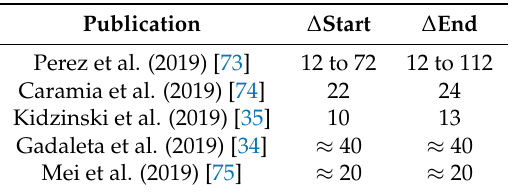
Table 2. State-of-the-art results: ∆ Start and ∆ End are displayed in milliseconds. Note that these results are only displayed for information since the used metrics, sensors and databases are not the same according to the publication. They only provide an order of magnitude of current performances in the literature.